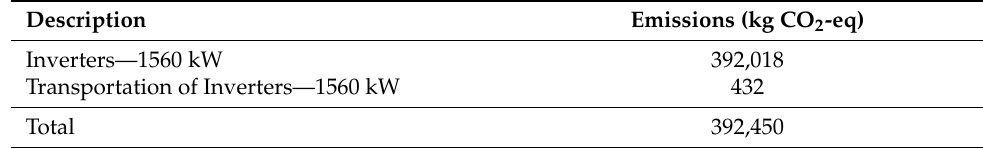
Table 4. GHG emissions associated with inverters.